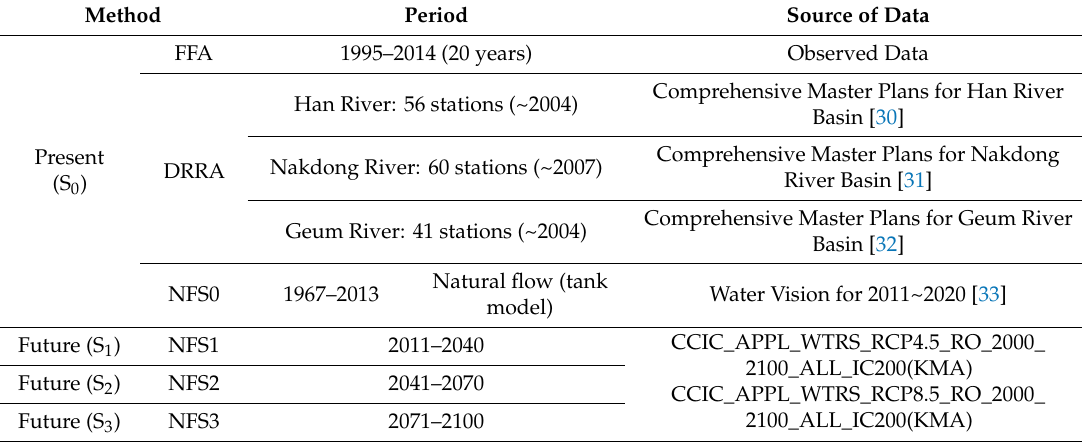
Table 1. Sources of data for estimating design floods.